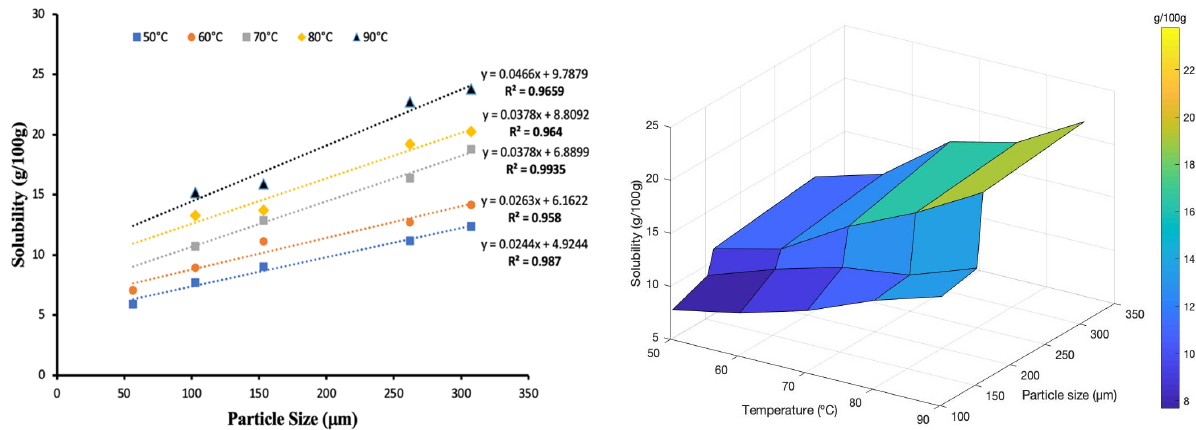
Figure 6. Correlation between particle size and solubility index.